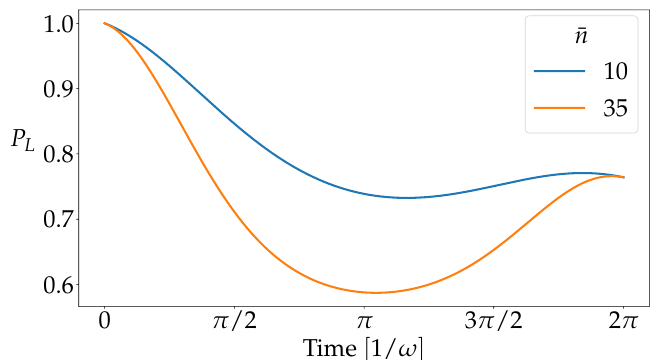
Figure 2. Revivals in the population of the | L (cid:105) state of the TLTM for different initial thermal states of the oscillator for the model in Equation (20) and the protocol described in Section 2. For the simulations presented here, we chose 2 αβ = 2 α 2 = β 2 /2 = 0.05 ω